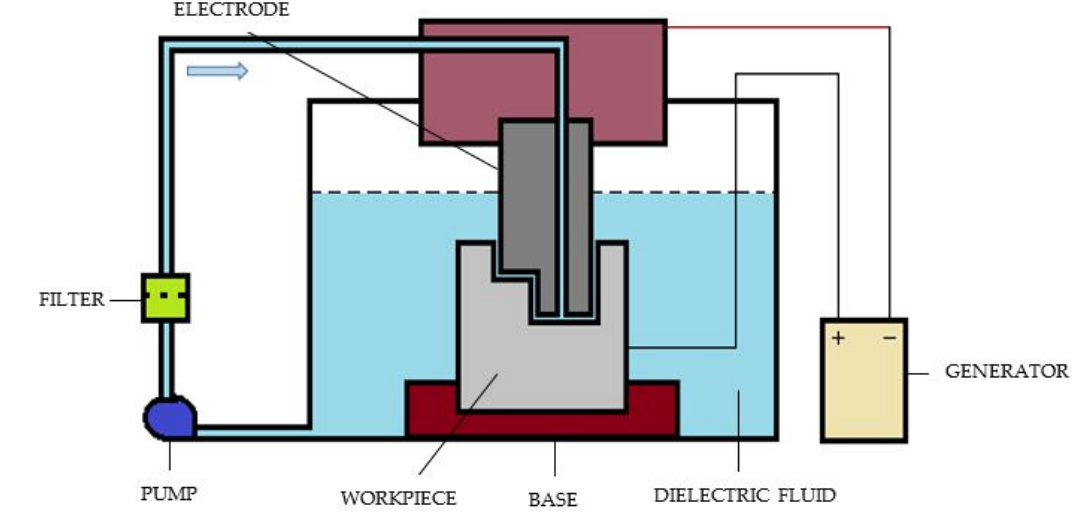
Figure 3. Schematic diagram of sinker EDM.